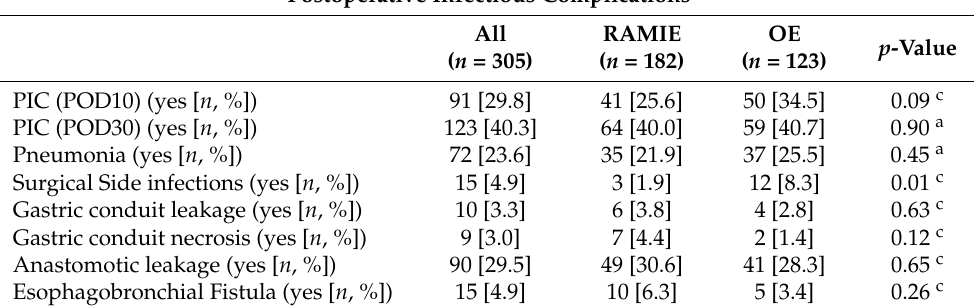
Table A1. PIC of patients undergoing RAMIE ( n = 160) or OE ( n = 145). Data are presented as number [relative frequencies] if not other stated, CDC Center for Disease Control; PIC: postoperative infectious complications, POD: postoperative day. Continuous variables were tested using a Students’ t -test (normally distributed) and b Mann-Whitney-U test (non-normally distributed), while categorical variables were compared using c